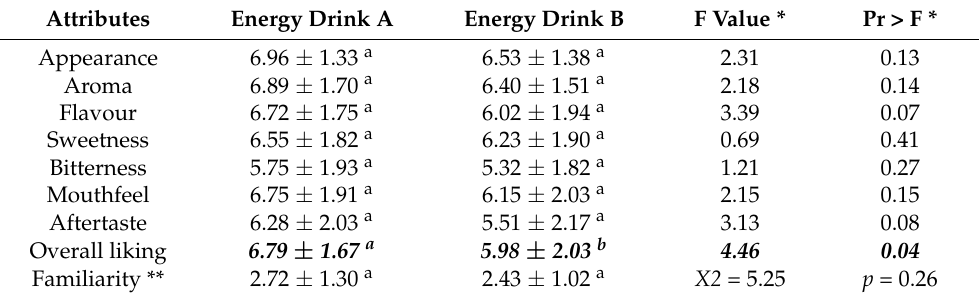
Table 2. Sensory attributes, overall liking and familiarity of energy drink A and B after